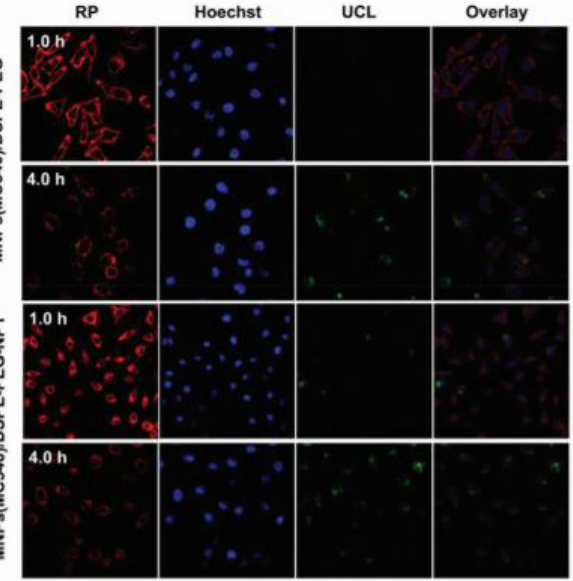
Figure 11. Confocal laser scanning microscopy of MCF-7 incubated with MNPs(MC540)/DSPE-PEG-NPY or MNPs(MC540)/DSPE-PEG. Reprinted with permission from reference [151]. Copyright 2018 Royal Chemical Society.